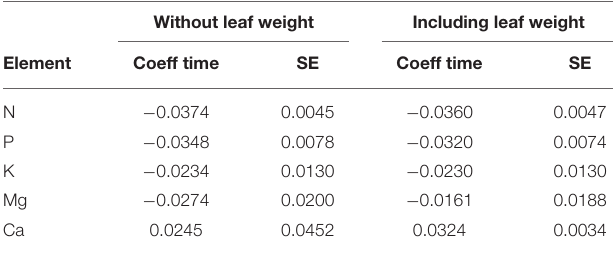
TABLE 6 | Comparison of the time coefficient of the regression model with the covariates listed in Table 1 (left two columns) and including leaf weight as additional covariate (right